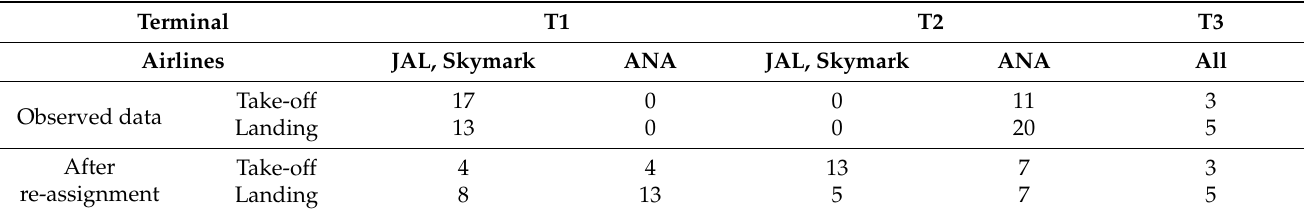
Table 4. Distribution of airlines in each terminal before and after gate re-assignment.